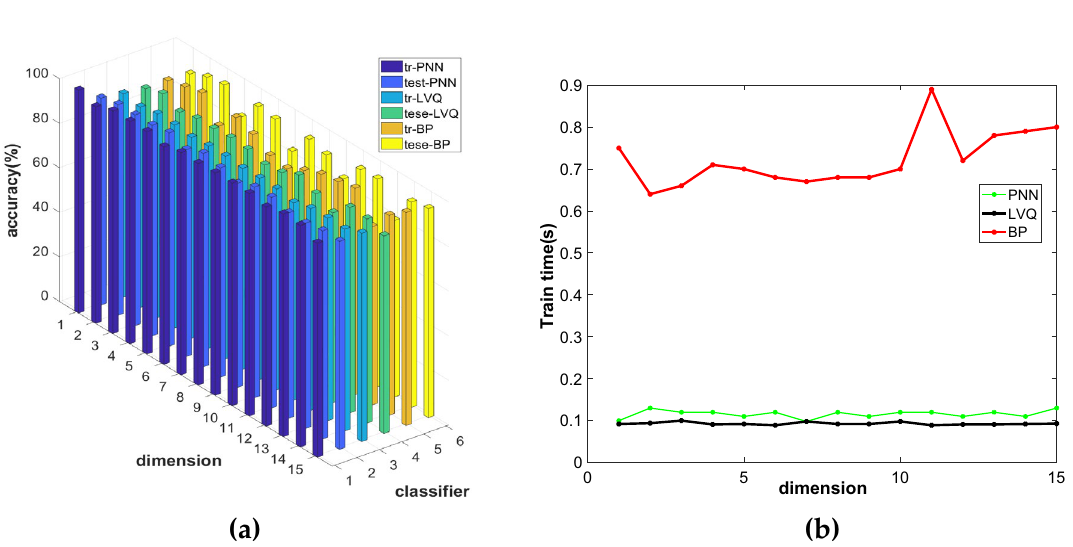
Figure 6. Comparison diagram of SPE-PNN, SPE-LVQ and SPE-BP models: ( a ) Accuracy comparison chart; ( b ) Comparison diagram of test time.